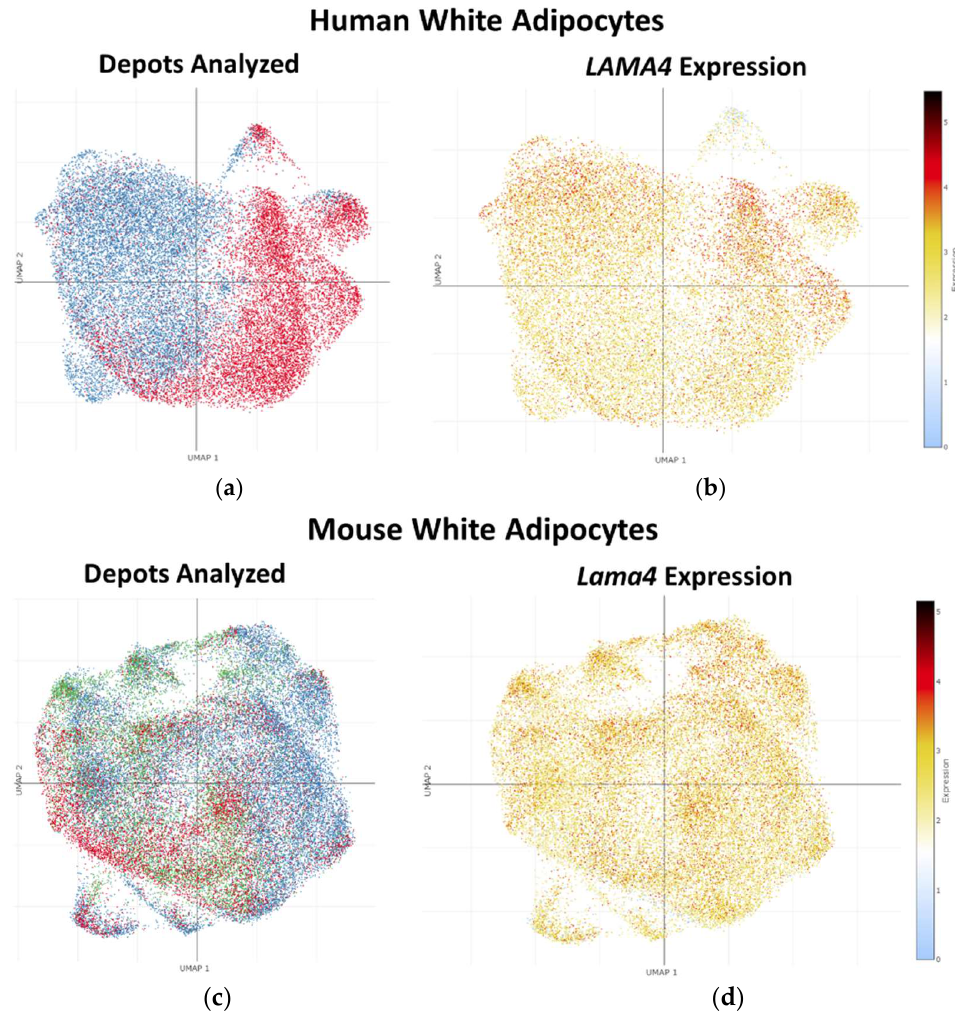
Figure 2. Laminin α4 is highly expressed in human and mouse adipocytes. ( a ) Uniform manifold approximation and projection (UMAP) embedding coordinates from single nucleus RNA-sequencing data for adipocytes from human WAT, red = omental depot (11,475 nuclei depicted) and blue = subcutaneous depot (14,396 nuclei depicted). ( b ) LAMA4 expression overlaid on the UMAP coordinates from ( a ). ( c ) UMAP embedding coordinates for adipocytes from mouse WAT, red = epididymal depot (7620 nuclei depicted), blue = inguinal depot (21,921 nuclei depicted), and green = periovarian depot (10,393 nuclei depicted). ( d ) LAMA4 expression overlaid on the UMAP coordinates from ( c ). Data used are from [13].